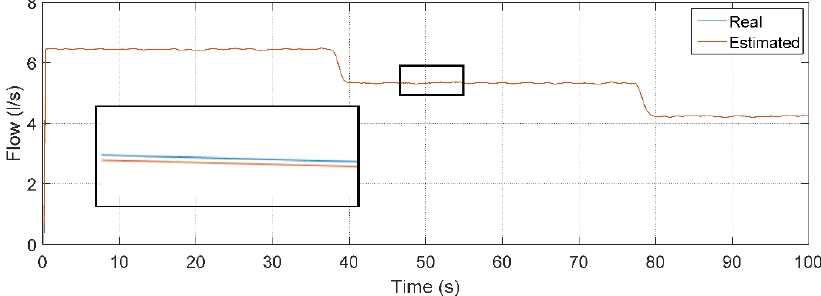
Figure 14. Measurement and estimation of flow during ANN testing using NARX.